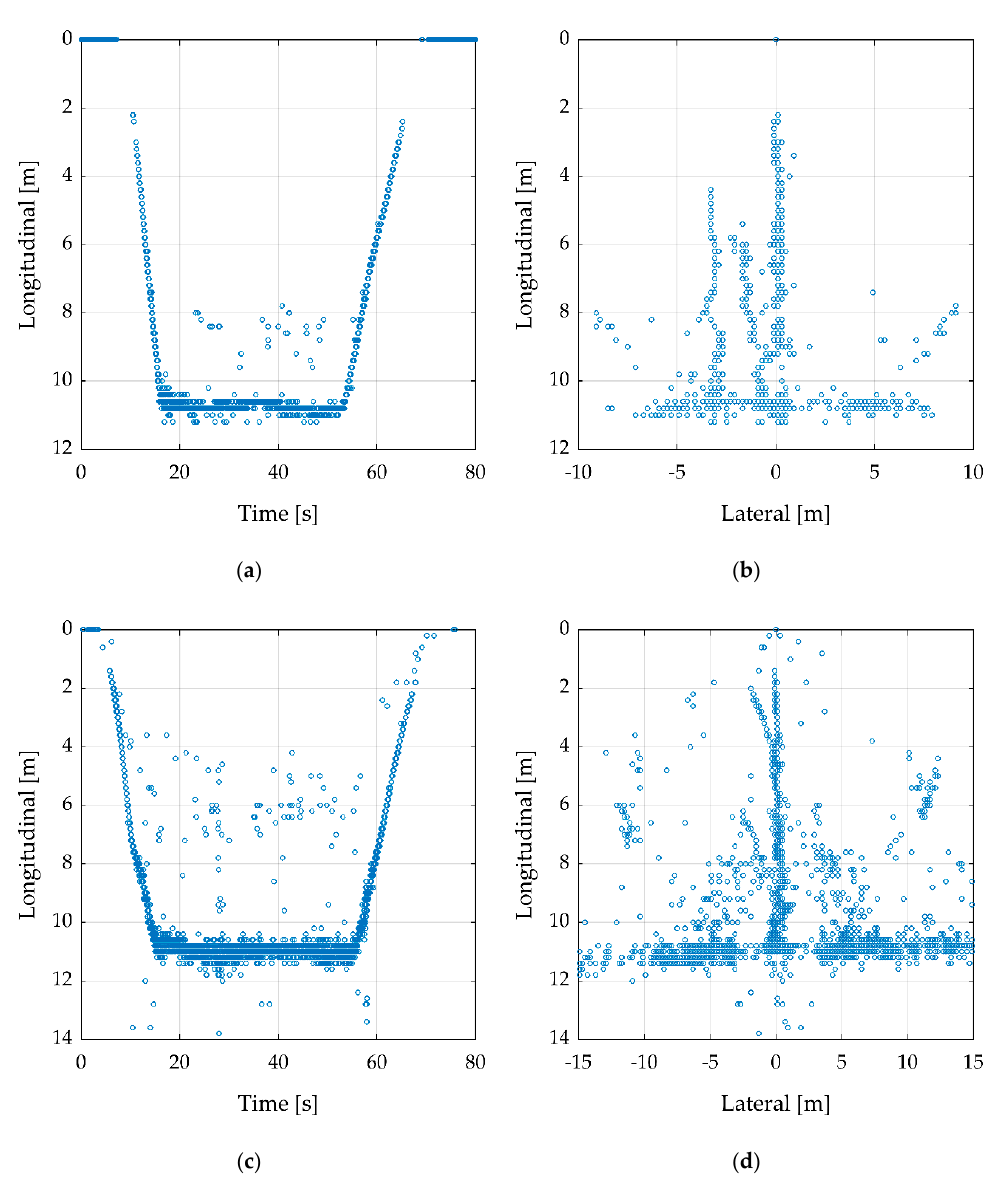
Figure 9. Based on Figure 8, this figure is filtered with min- and max-filters by the values shown in Table 4. ( a, b ) with the radar sensor ARS-404, ( c, d ) with ARS-408. Table 4. Filter setup for the min- and max-filter to improve Figure 8.